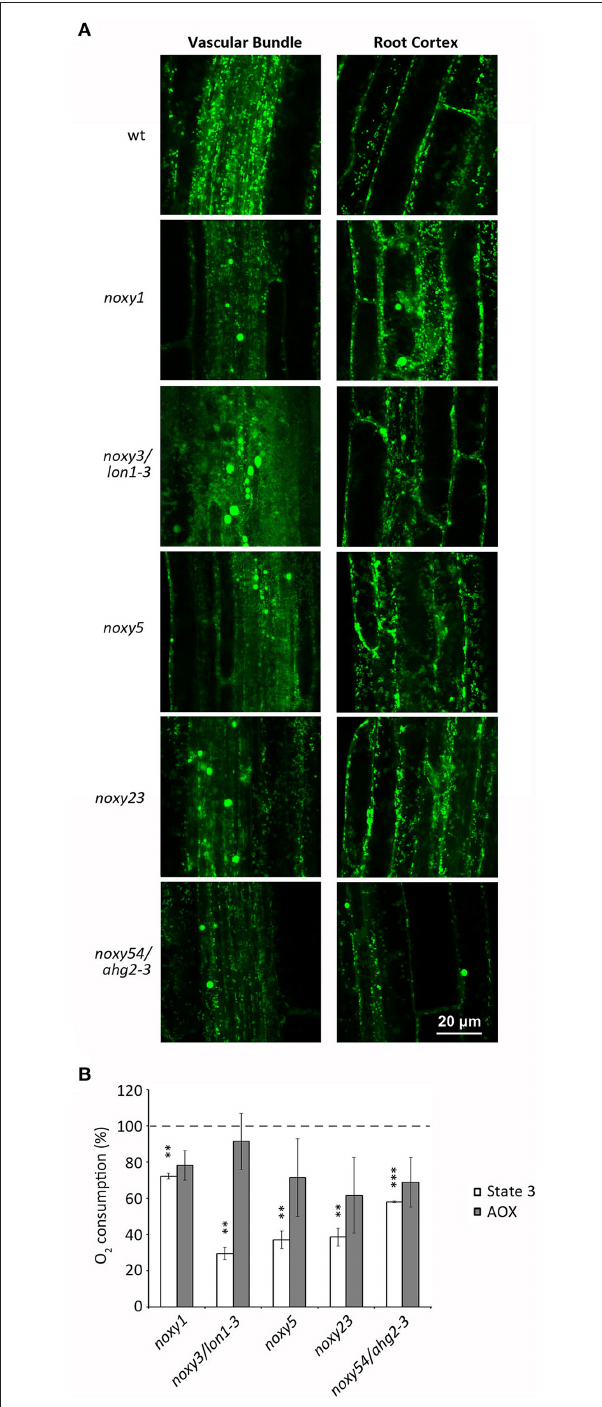
FIGURE 2 | Analysis of mitochondrial distribution and function in wild type, noxy1 , noxy3/lon1-3 , noxy5 , noxy23 , and noxy54/ahg2-3 plants. (A) Confocal images of mitochondria-tagged mt-YFP in the root vascular bundle (left) and cortex (right) showing abnormal accumulates in noxy plants. (B) Oxygen consumption rates of cytochrome (State 3) and alternative (AOX) pathways in mitochondria isolated from noxy mutants, relative to wild type mitochondria. Asterisks indicate significant differences with wild type plants in each condition ( n = 4, Student’s t -test, *** P < 0.001, ** P < 0.01.